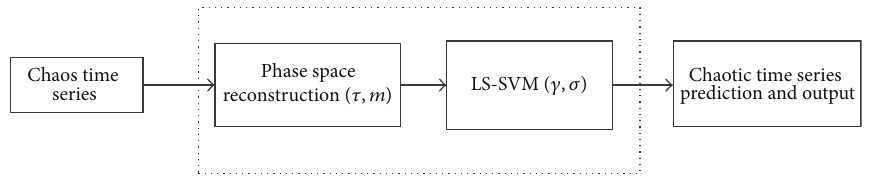
Figure 1: The flow chart of chaotic time series